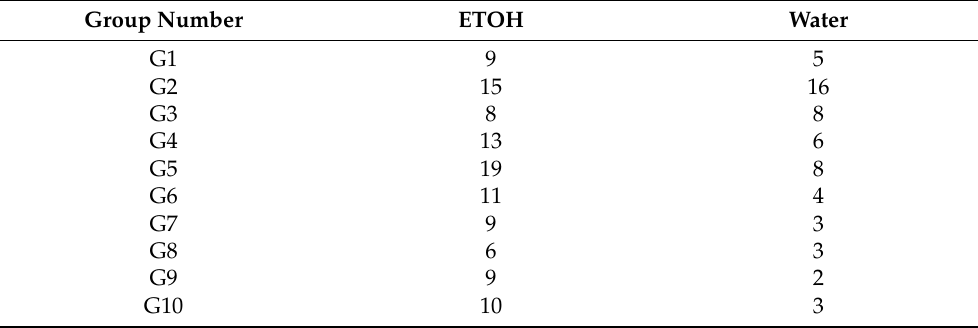
Table 1. The numbers of fruit flies in the ETOH chamber and water chamber at the end of the ex ‐ periment.